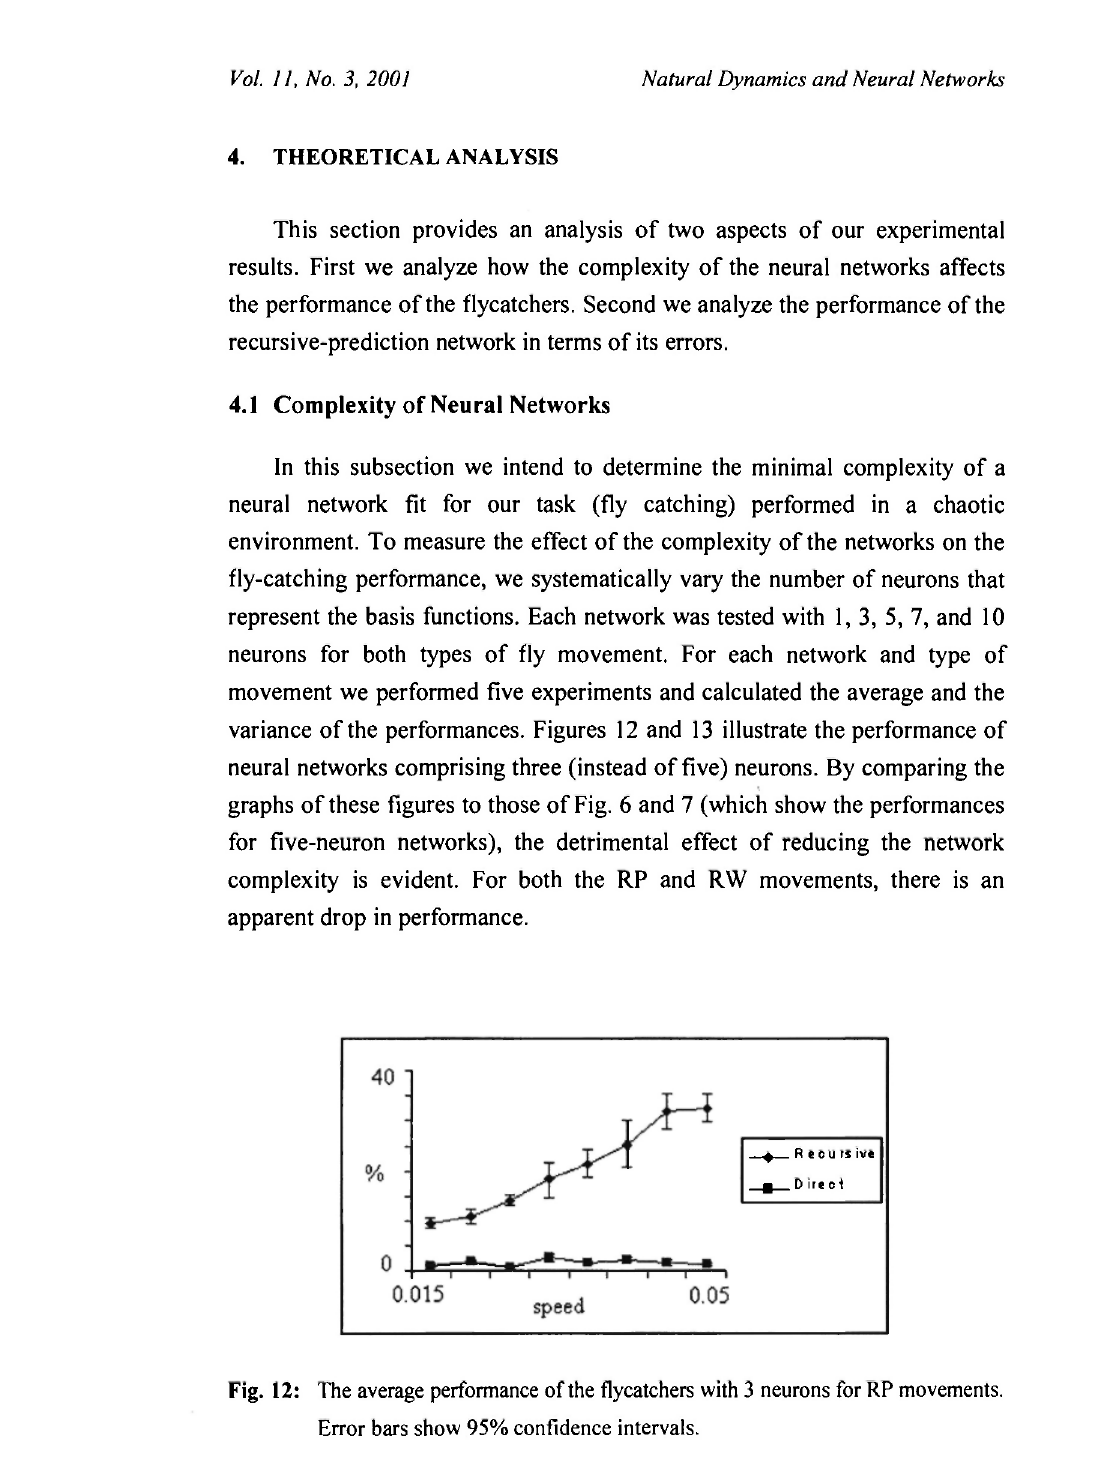
Fig. 12: The average performance of the flycatchers with 3 neurons for RP movements. Error bars show 95% confidence